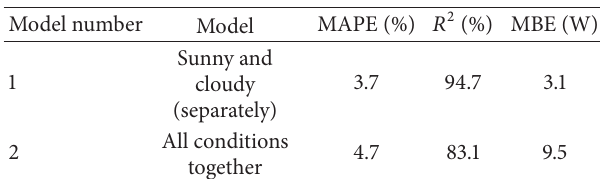
Table 3: The generated error in PV panels’ power prediction using